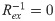
Ephaptic coupling reduces AP speed and leads to AP synchronisation.A: Depolarisation curves for a pair of action potentials with initial offset of 0.02ms converge, reducing the time difference between action potentials. B: Depolarisation of a synchronous pair of action potentials is slower than for a single action potential. C: An action potential induces initial hyperpolarisation and subsequent depolarisation in an inactive neighbouring axon. Parameters: standard parameters, Rex-1=0.